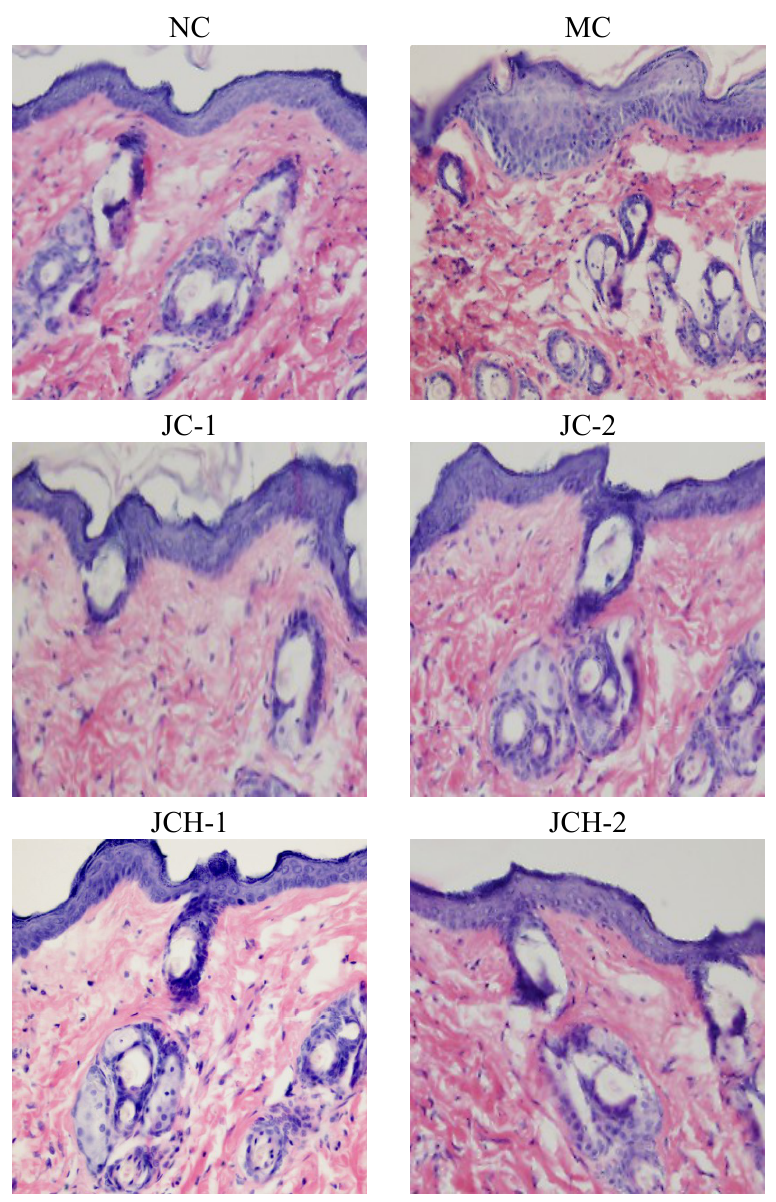
Figure 1. The effect of JC and JCH on morphology of photoaging skin (magnification